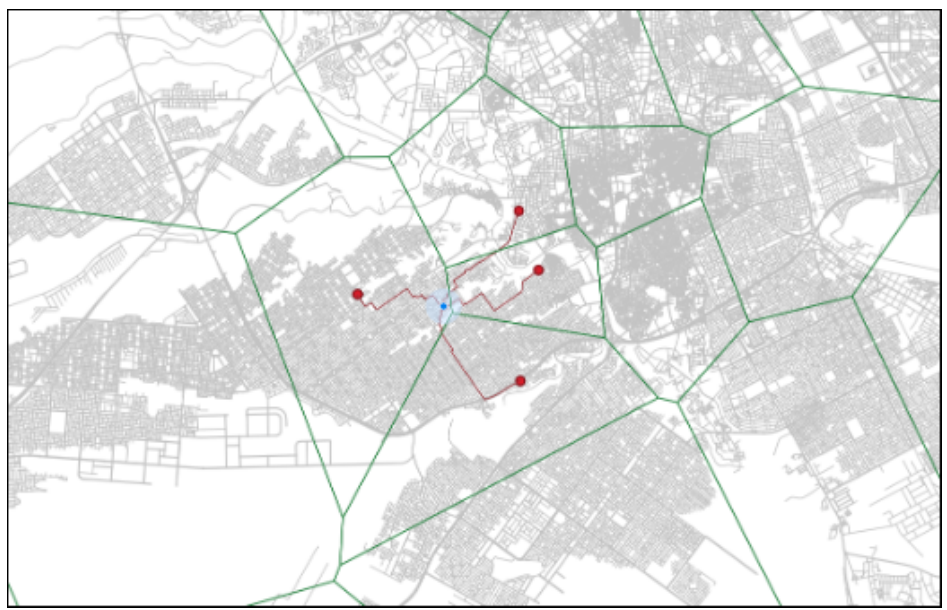
Figure 10. Candidate ambulance units within the catchment areas.